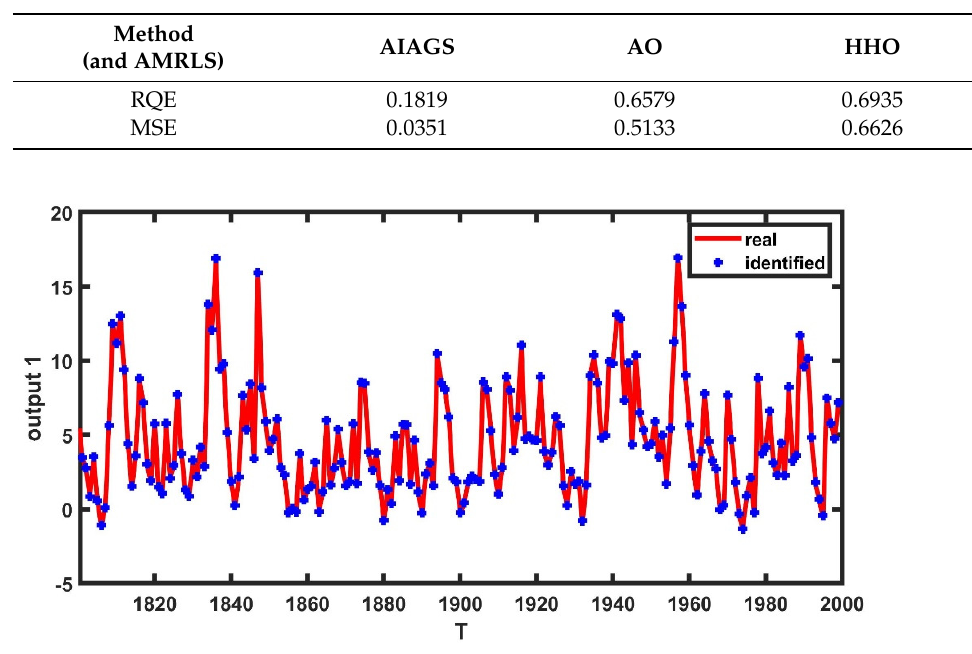
Table 7. The RQE and MSE of the results.